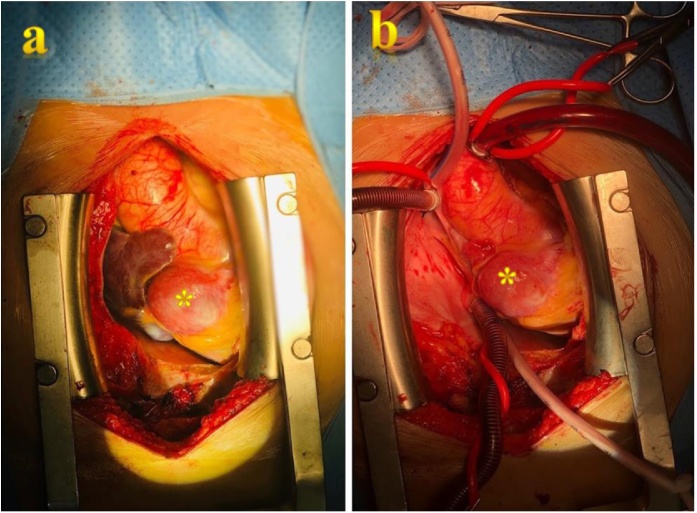
(a) The intraperative image of proximal aneurysmal sac (*). (b) The cardiopulmonary bypass was set through the ascending aorta, superior and inferior vena cava.